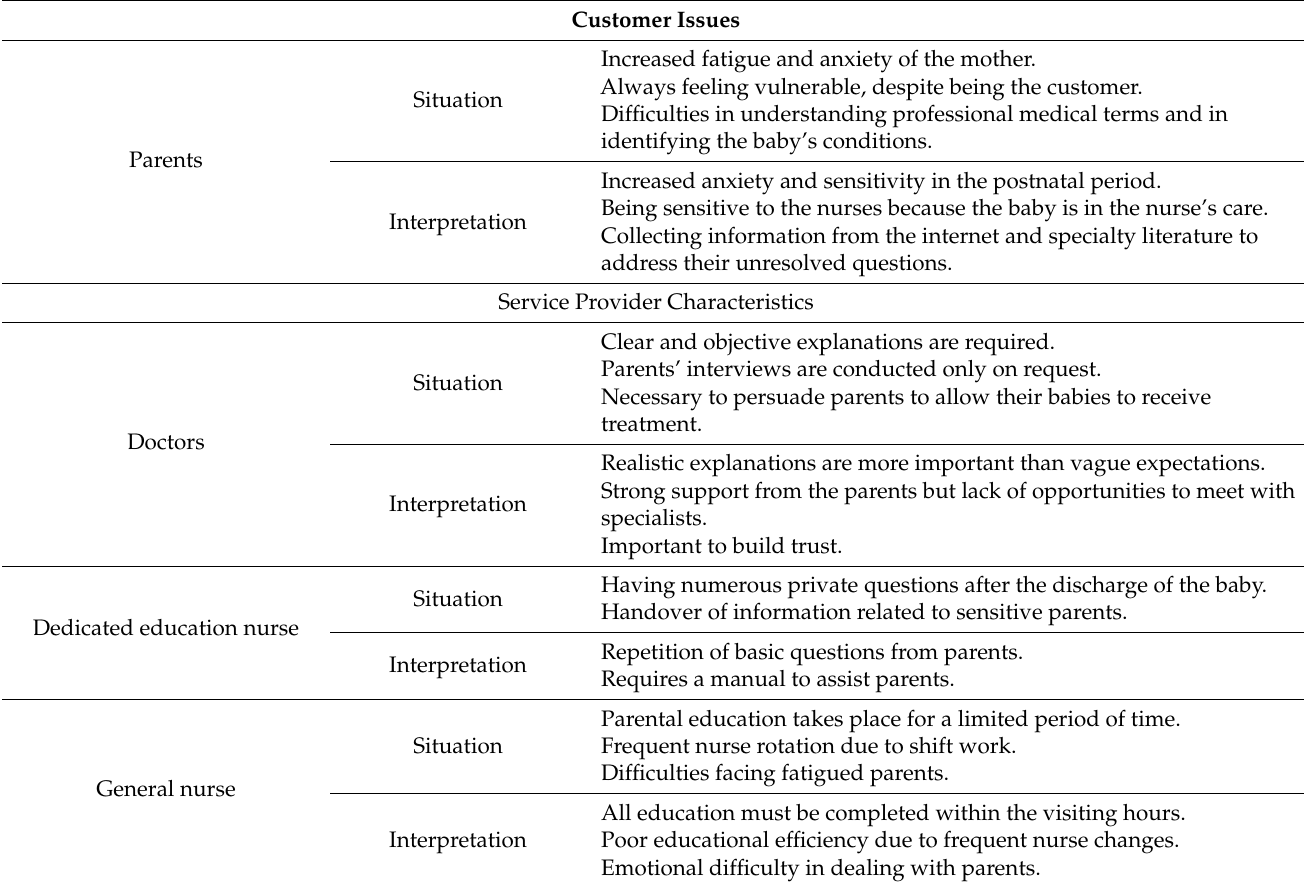
Table 1. Issues of key stakeholders and needs of